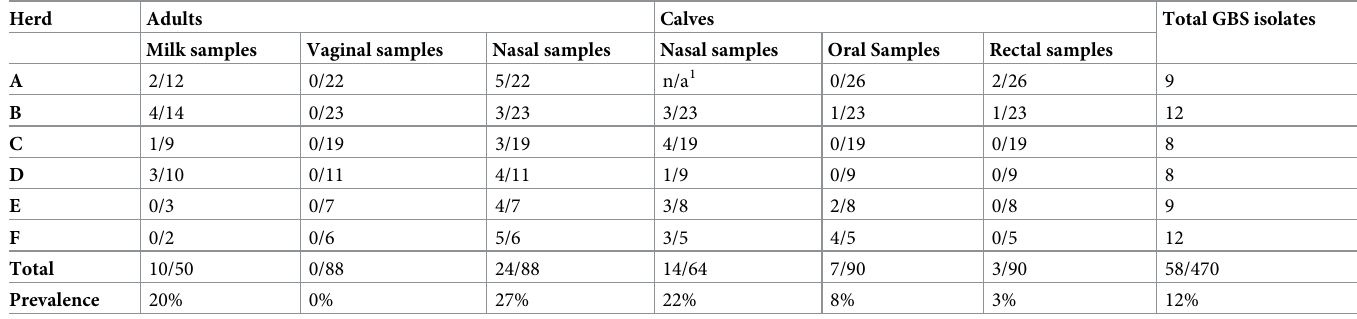
Prevalence (GBS-positive samples/total number of samples, with prevalence expressed as % for column totals). 1 No nasal swabs were collected from calves in herd